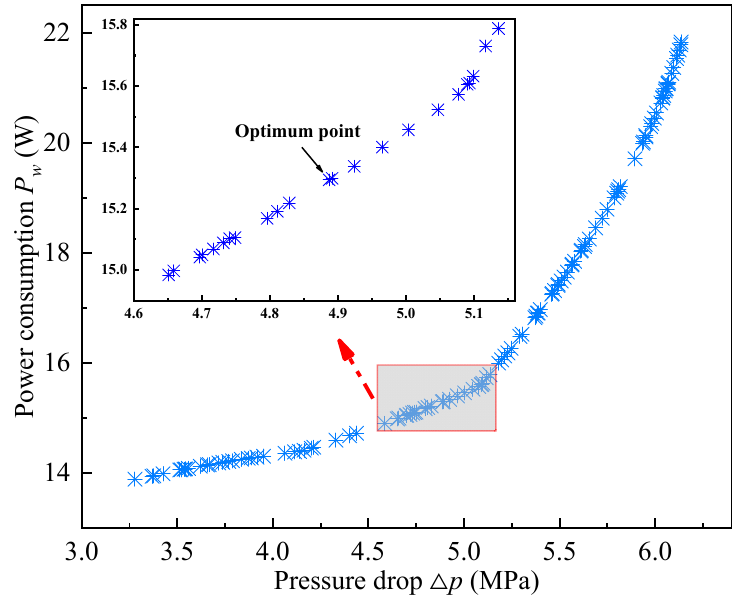
Figure 12. Optimal Pareto front.